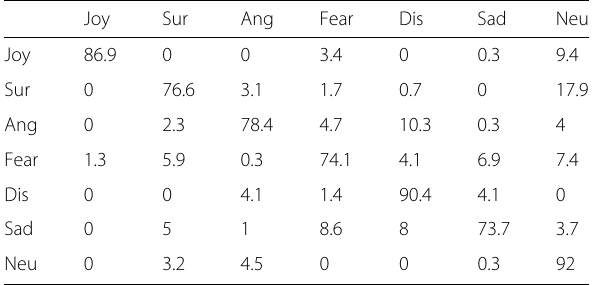
Table 12 Confusion matrix (%) of cross-validation testing method for 7-class emotion in JAFFE dataset using Improved